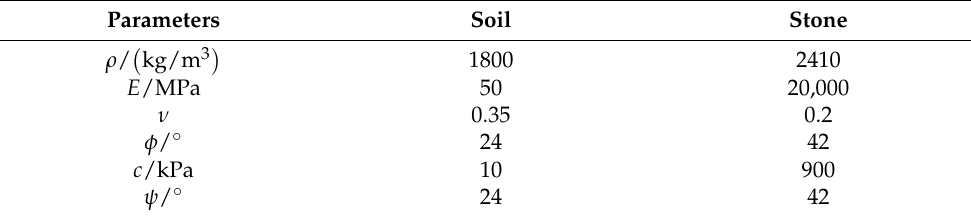
Table 1. Mechanical parameters of the SRM slope.